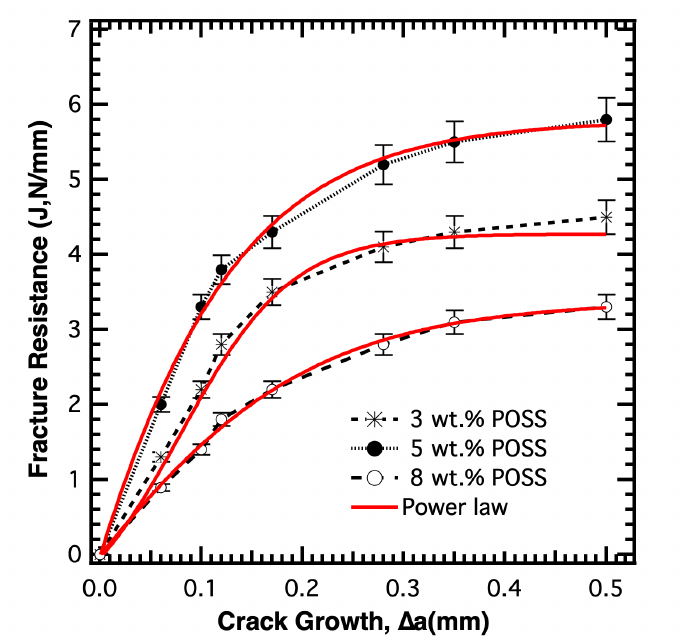
Figure 5. Variation of J value with the increase in crack extension, for different percentage of glycidyl